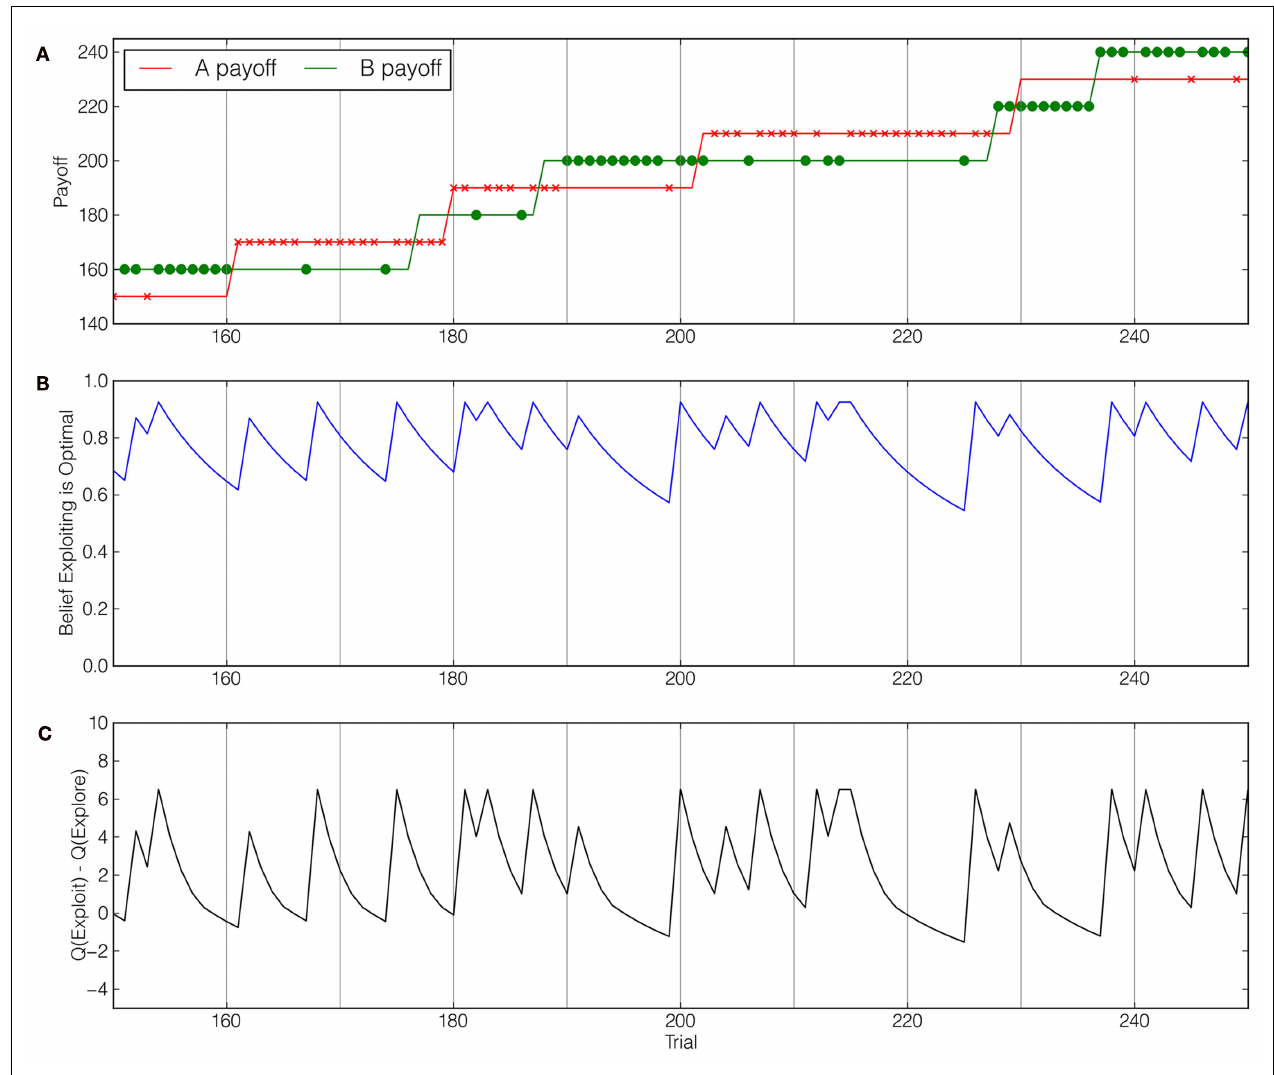
among these options. (B) The Ideal Observer’s belief that the exploitative options will yield larger the higher payoff – and thus the higher immediate reward – at each trial in the task instantiation at top. Note that the subject’s certainty about the options’ relative payoffs generally decreases during exploitation-only runs. (C) The relative long-term value of the exploitative option at each trial as determined by the Ideal Actor, using the beliefs from (B) and an optimal valuation function. Also note that changes in the relative value follow changes in belief in a non-linear